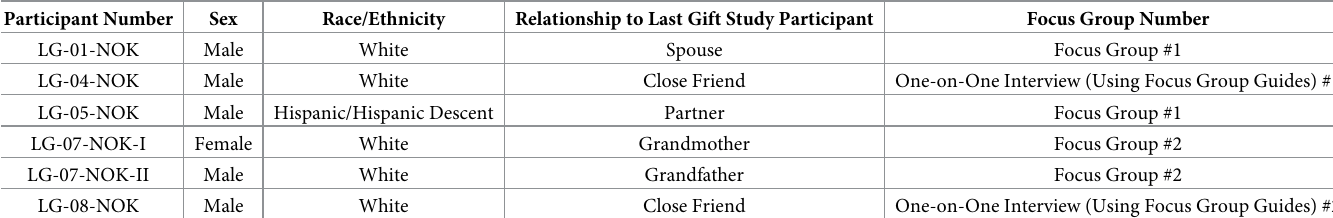
Table 2. Demographic characteristics of NOK/loved ones who responded to focus group guide questions (San Diego, California, 2019).